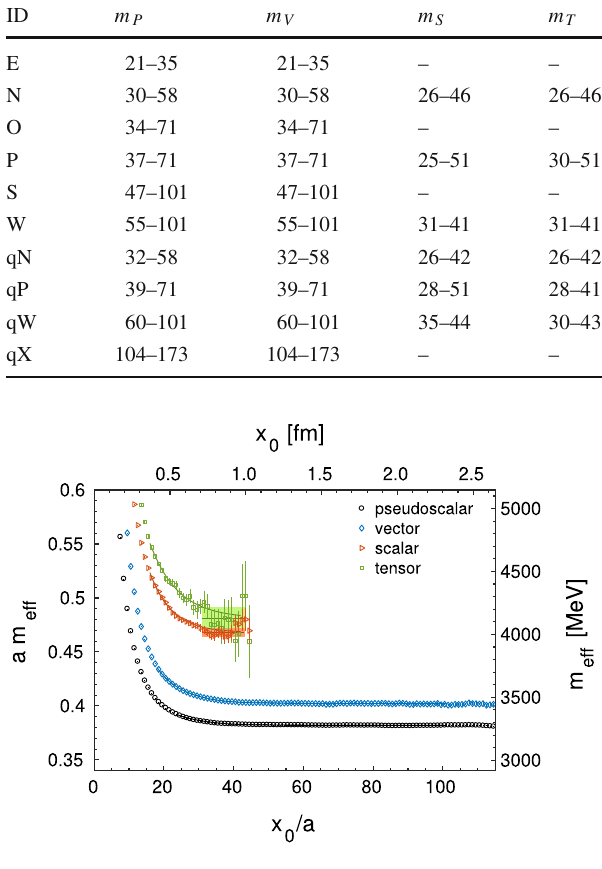
of order a 2 . This means, neglecting data with lattice spacings coarser than a 2 / t 0 > 0 .